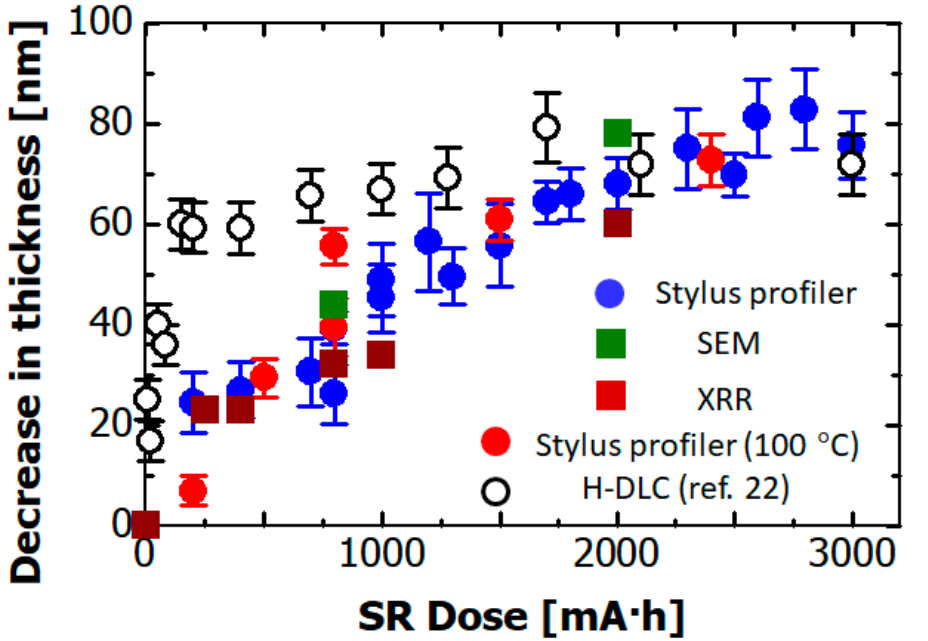
Figure 2. Synchrotron radiation (SR) dose dependence of the reduction in film thickness of the hydrogenated Si-DLC film measured with a stylus profiler (blue circles), SEM (green squares), and X-ray reflectivity (XRR, brown squares). Red circles indicate reductions in film thickness acquired by the stylus profiler in case of substrate heated to 100 ◦ C with a heating system. Open circles indicate reductions in the film thickness of non-doped hydrogenated DLC (H-DLC) film after SR exposure [22].